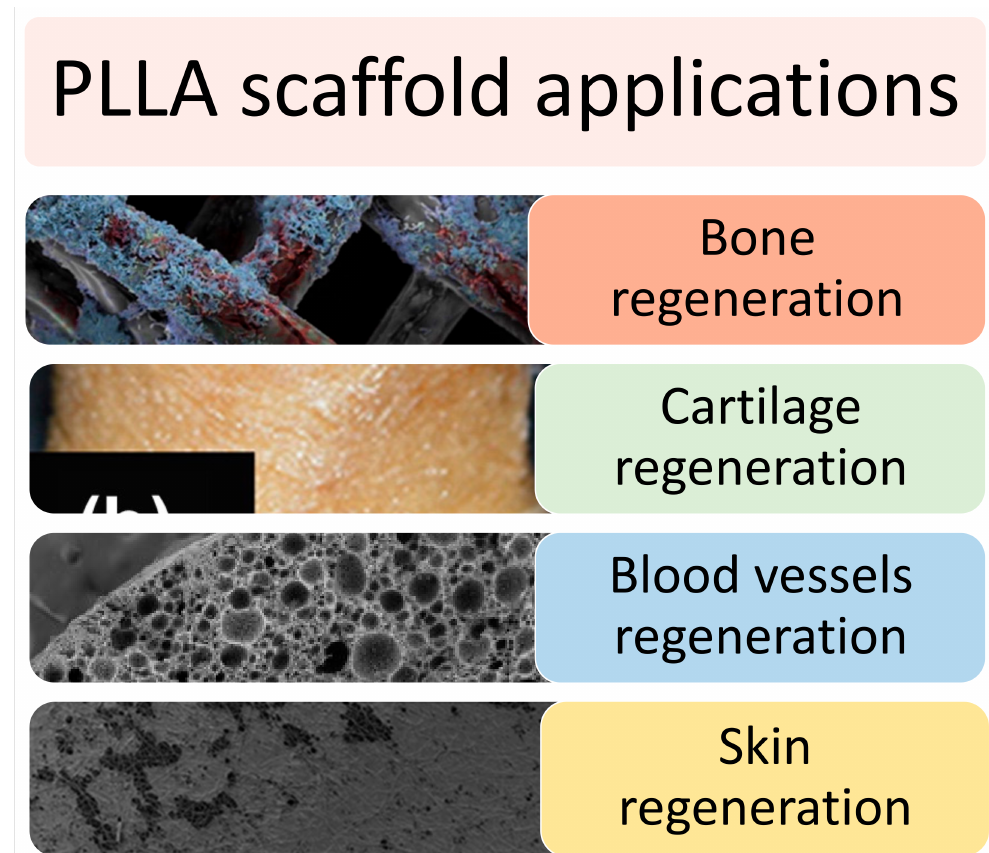
Figure 11. Structure of PLLA-based scaffold designed for bone, cartilage, blood vessel, and skin regeneration. Reprinted with permission from Elsevier [82], Taylor & Francis [113], Dovepress [161], and RSC